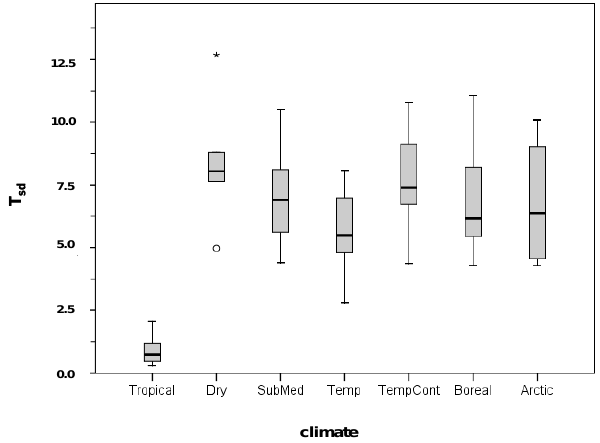
Fig. 3. Hypothetical relationship between soil respiration at mean annual temperature (SR MAT ) and total soil annual respi- ration (SR annual ) for 1000 random combinations of SR MAT , T sd and Q 10 , as obtained by a Monte Carlo simulation. Regression: SR annual =455.8SR 1 . 0054 , R 2 =0.94, p< 0.001. Numbers in graph MAT indicate Q 10 and T sd for exceptionally high values of SR annual